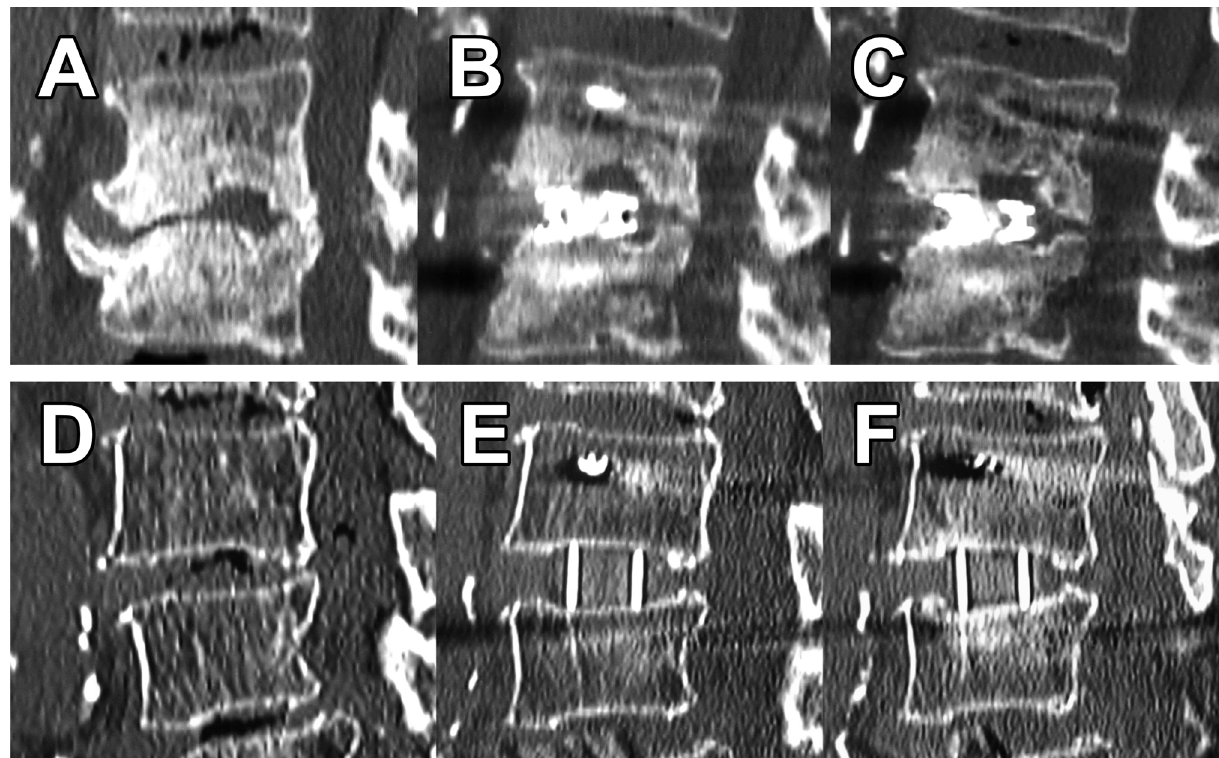
Figure 6. Differences in postoperative changes depending on cage. ( A) , preoperative degenerated interbody; ( B) , postoperative VEC caused by the 3DTi cage; ( C) , no further subsidence after 3 interbody; ( B ), postoperative VEC caused by the 3DTi cage; ( C ), no further subsidence after 3 months. months. ( D) , preoperative; ( E) , postoperative VEC caused by the sPEEK cage; ( F) , cage subsidence ( D ), preoperative; ( E ), postoperative VEC caused by the sPEEK cage; ( F ), cage subsidence and and decreased lordosis (11° to 6°) after three months. decreased lordosis (11 ◦ to 6 ◦ ) after three